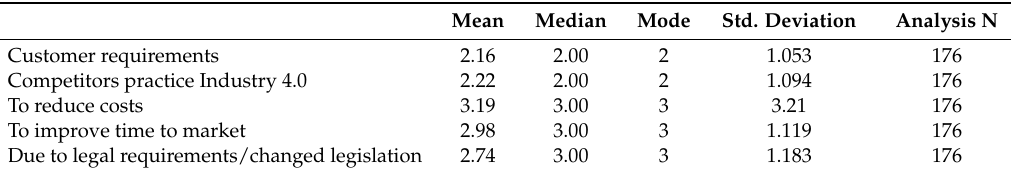
Table 5. Descriptive